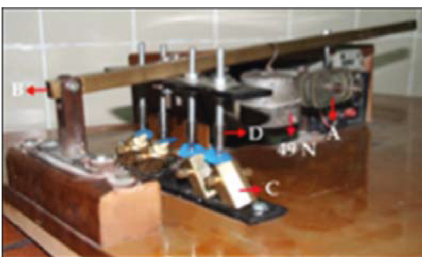
Figure 12: Specimens subjected to cyclic load. A, motor drive connected to an oval-shaped acrylic block with a metal rod; B, the metal arm fixed to the base of the machine from the one end and the other end carrying a metal block 49N; C, four custom-made copper molds, carrying the specimens; D, four metal stylus, each one ended with 7 mm × 2mm diameter beveled metal